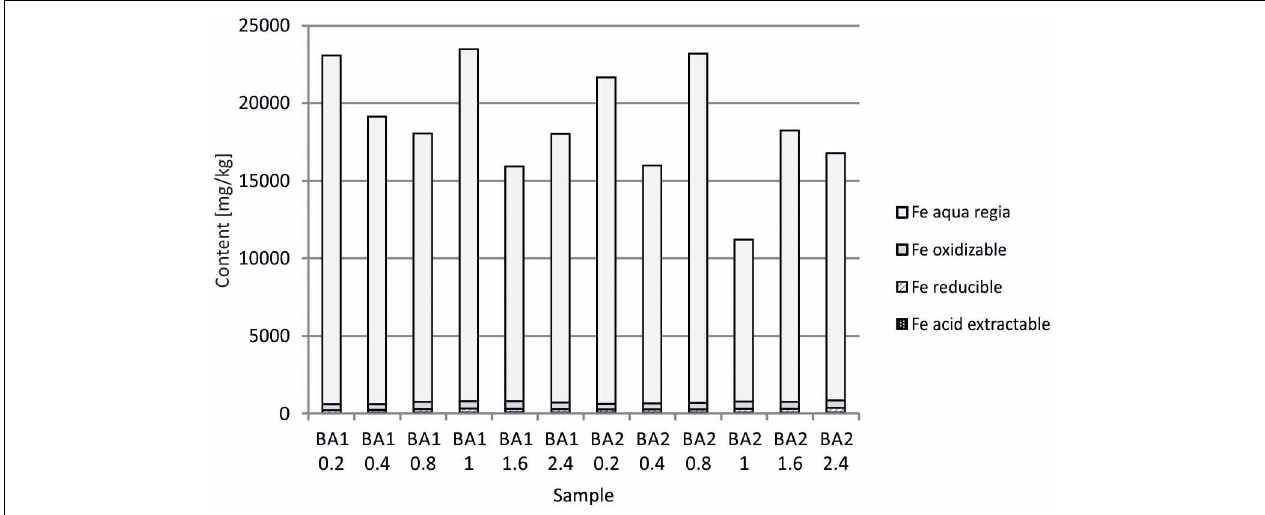
FIGURE 10 | Sequential extraction of the Berg Aukas samples: